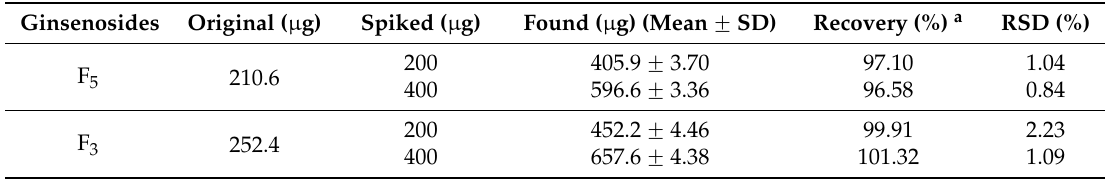
Table 4. Recovery of ginsenoside F 5 and F 3 ( n =